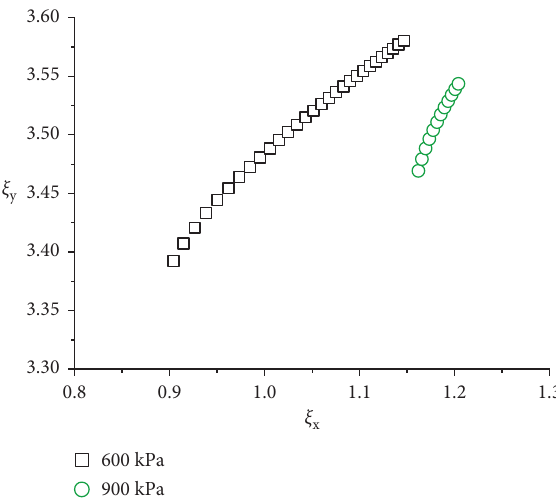
Figure 13: Various stress path tests of granite rockfill materials